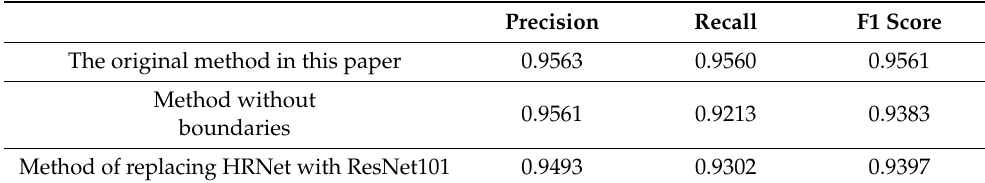
Table 1. Results comparison of ablation studies.